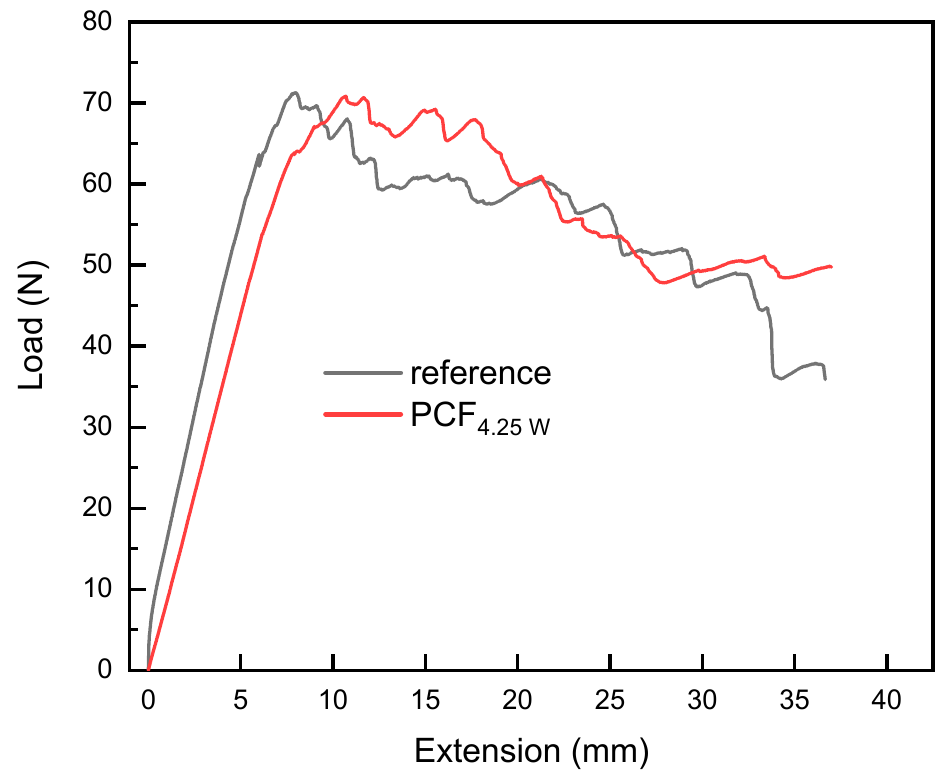
Figure 11. G Ic load (N) versus displacement (mm) representative curve for reference and PCF 4.25 W samples.